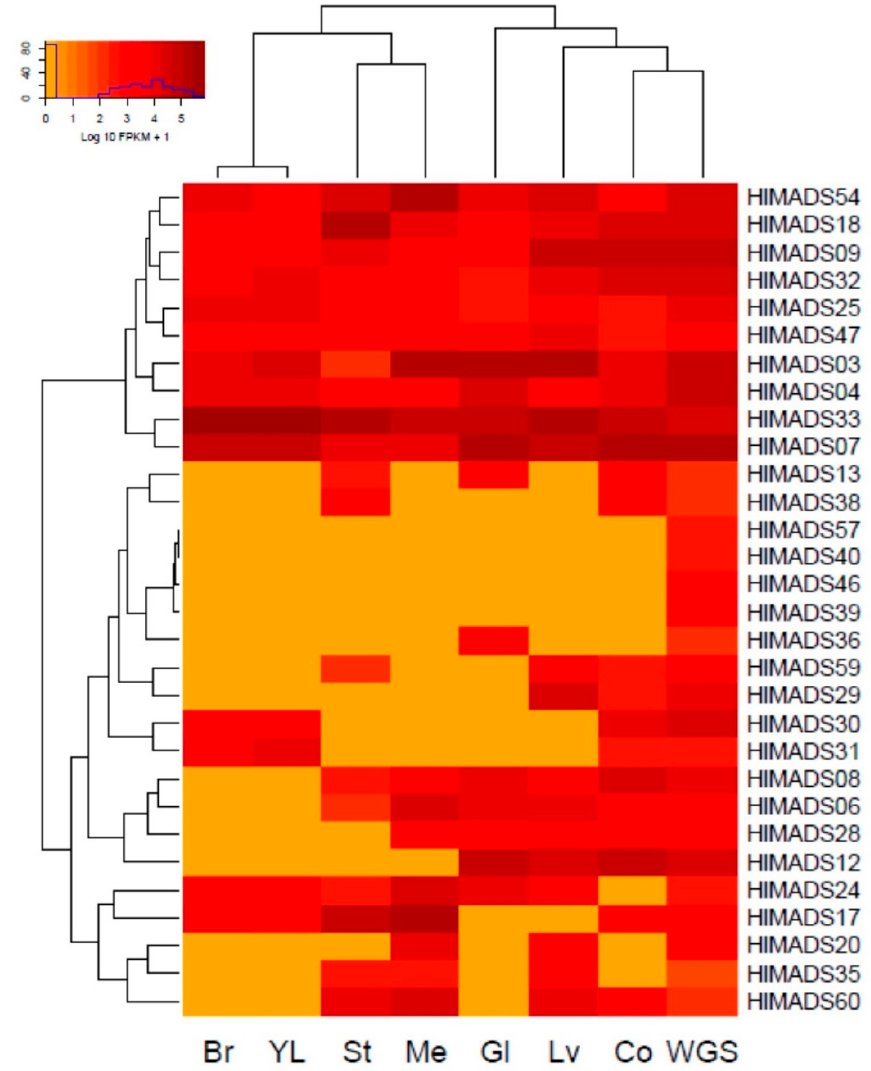
Figure 5. Expression profiling of hop MADS-box genes in RNA-Seq libraries: bracts (Br), young leaves (YL), stem (St), vegetative meristem (Me), glands (Gl), mature leaves (Lv), cones without glands (Co), and a mélange of plant tissues collected throughout the whole growing season (WGS). We identified two gene groups regarding the expression profile (Figure 5). The first encompassed constitutive genes: two SEP ( HlMADS03 and HlMADS04 ), two TM8 ( HlMADS09 and HlMADS18 ), two AGL6-like ( HlMADS07 and HlMADS33 ), one of the C/D (AG) subfamily ( HlMADS32 ), and three type-I α ( HlMADS25 , HlMADS47 , and HlMADS54 ). The second group included 20 genes (9 type-I and 11 MIKC c ) that showed variable expression among the samples. The B (AP3-PI) subfamily member, HlMADS13 , was expressed in the stem, glands, and cones, whereas four type-I genes ( HlMADS57 ,